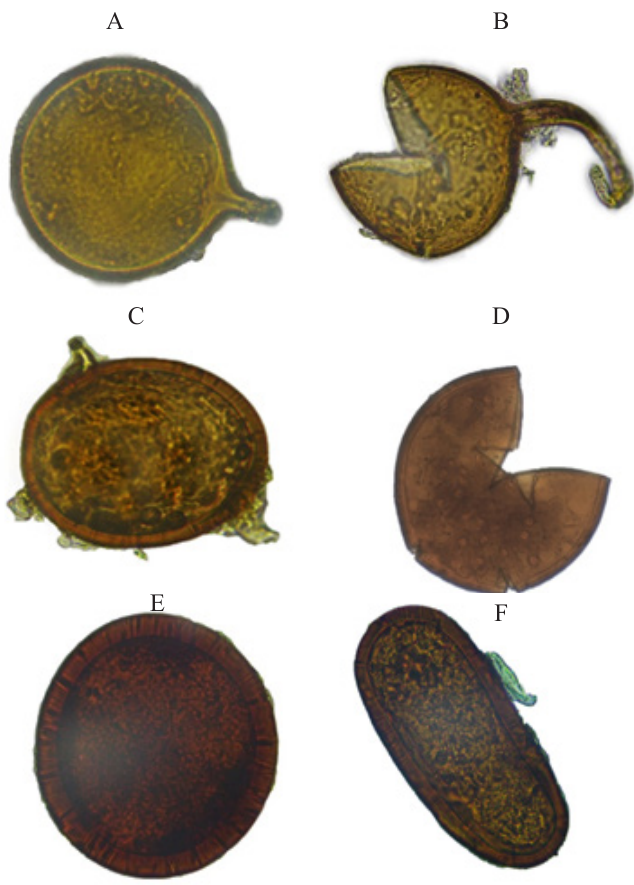
Figure 4: Some AMF spores isolated during the study belonging to Glomus (A-C), Acaulospora (D), Gigaspora (E) and unidentified morphotype (F). Photographs were taken using an Optika Vision Lite 2.13 (at × 400 magnification) Table 2: Arbuscular mycorrhizal fungi (AMF) spore characteristics in three land use types, lowland rainforest (LR), shrub-dominated site (SD) and Dicranopteris -dominated fernland (DD) in Kanneliya Forest Reserve in the Sri Lanka Lowland Rainforest (LR) Shrub-dominated site (SD) Dicranopteris Fernland (DD)